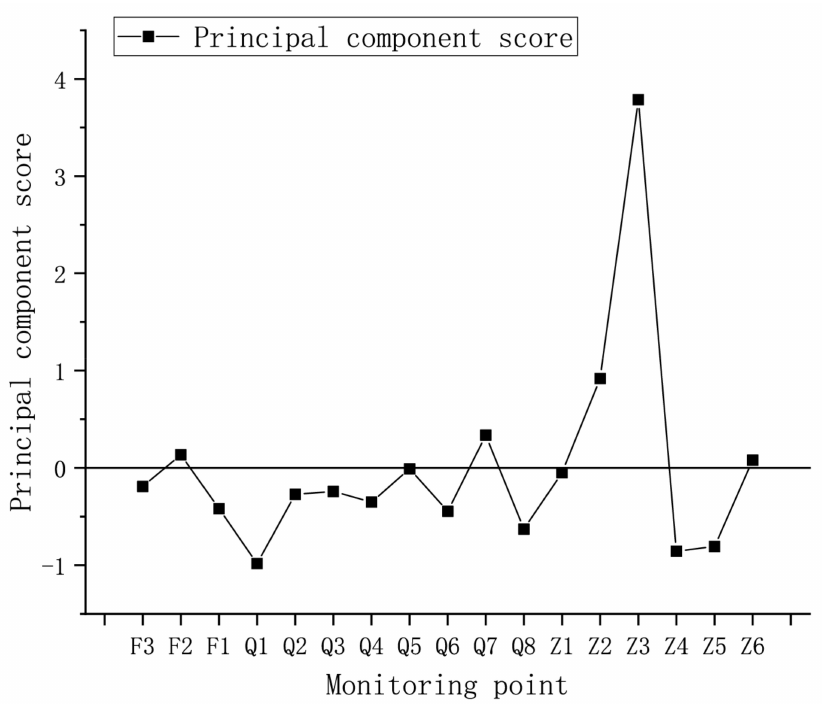
Figure 5. Results of the principal component scores for 17 monitoring